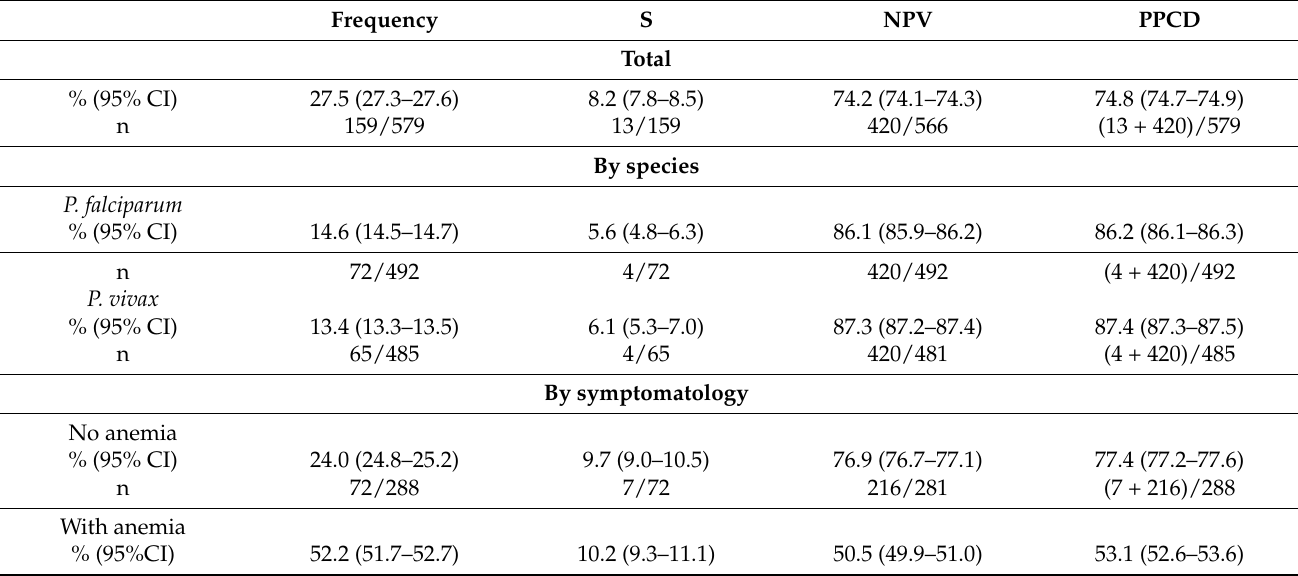
Table 5. Diagnostic evaluation parameters of the TBS compared to qPCR for the diagnosis of placental malaria in the total population and in subgroups according to species, symptomatology, and history of